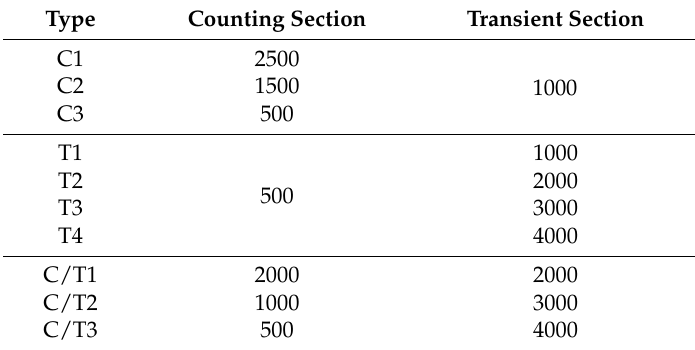
Table 2. Micro-viscometer specifications for the parametric